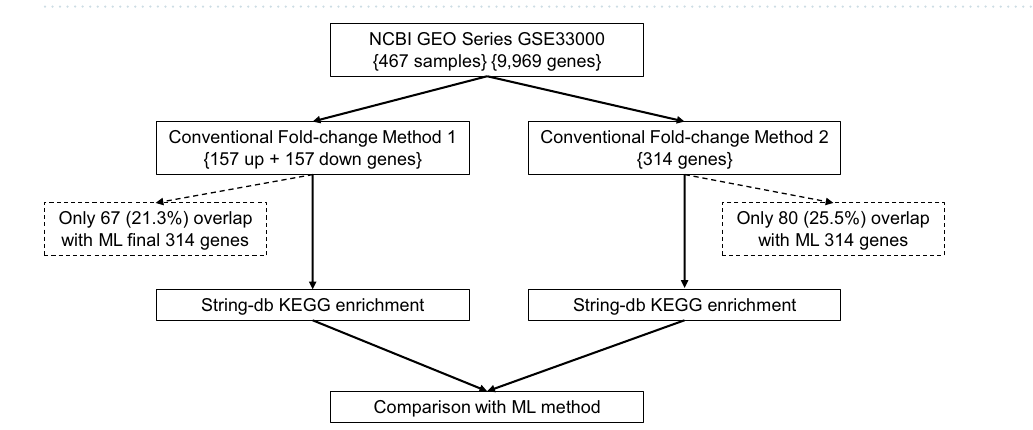
Figure 2. The performance of various ML models. A) ROC curves and B) precision recall (PR) curves of the ML models used in this study.